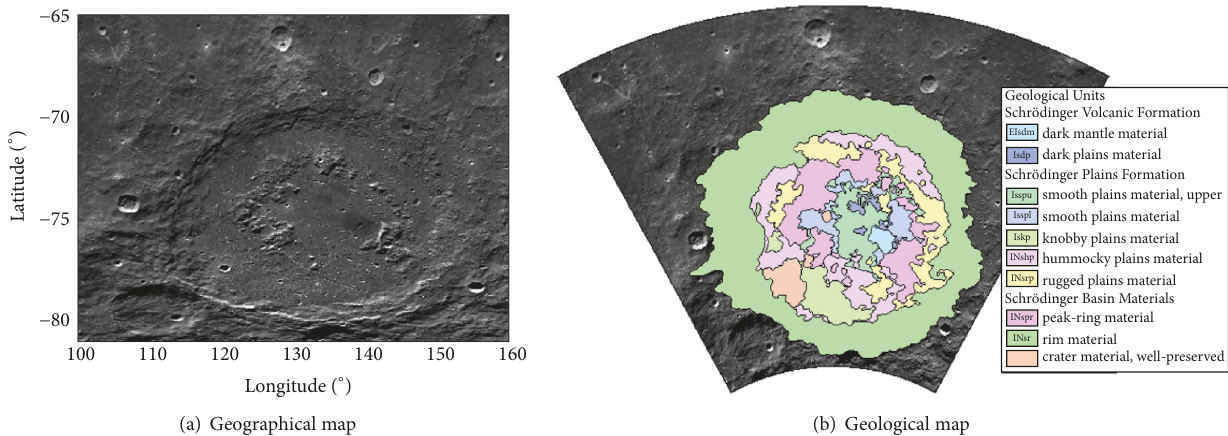
Figure 1: WAC image (a) and geological map (b) of Schr¨odinger basin. Note: Figure 1(a) was downloaded from http://wms.lroc.asu.edu/ lroc/search. Figure 1(b) geological map is interpreted by Mest [2].